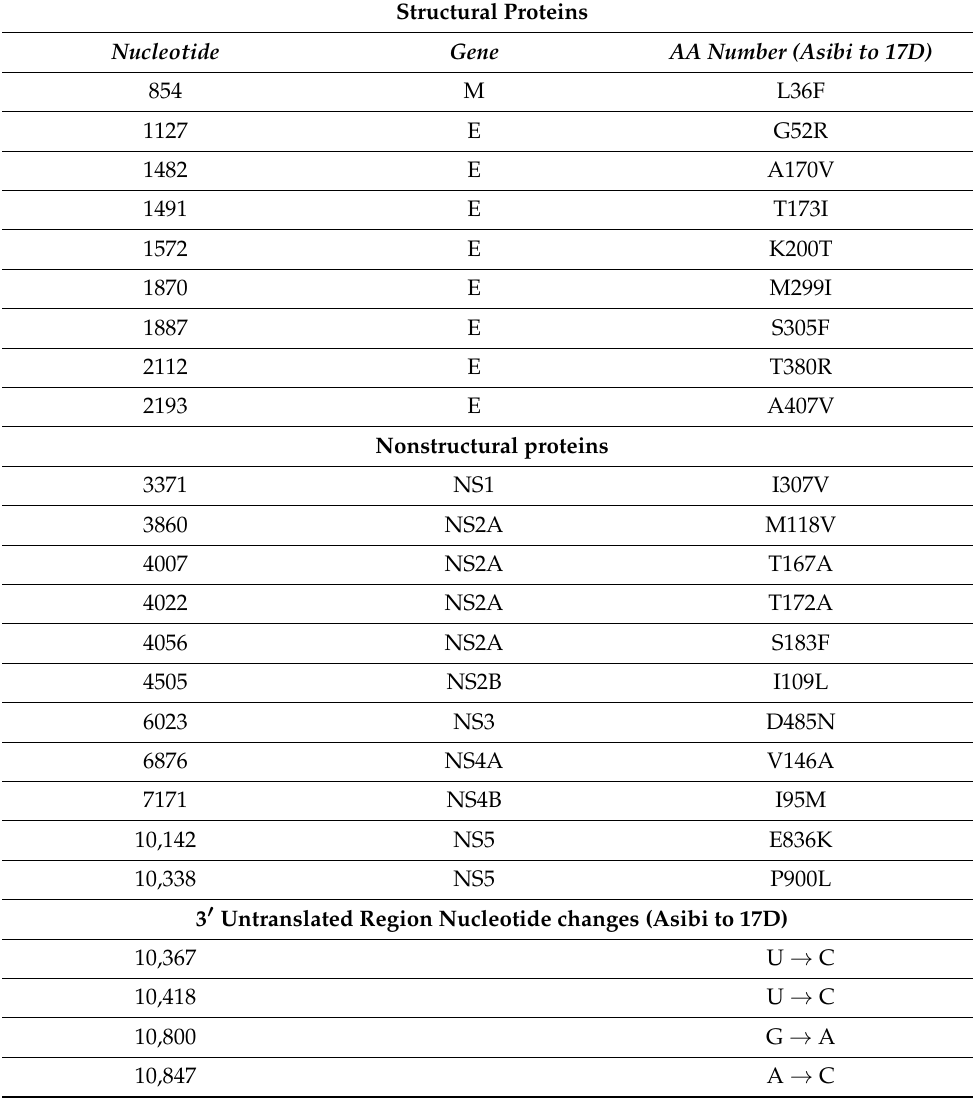
Table 1. Amino acid substitutions and nucleotide changes between Asibi and 17D YF strains [4]. Structural Proteins Nucleotide Gene AA Number (Asibi to